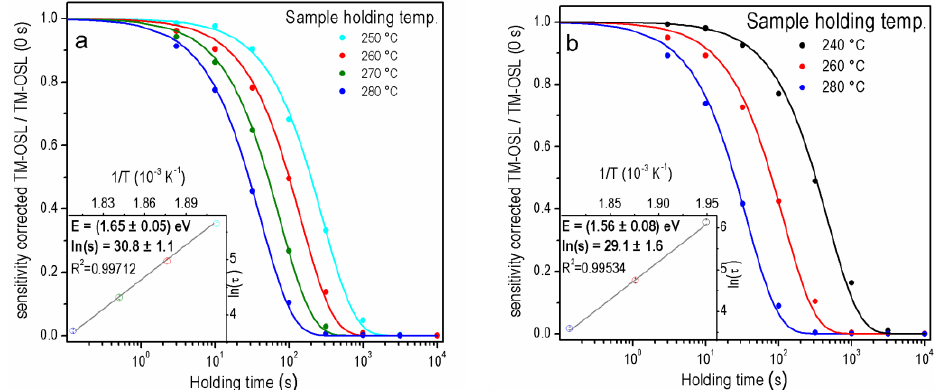
Figure 4. The OTDCs for one aliquot of the FB sample using TM-OSL 620 nm procedure after irradiation with dose 1000 Gy and preheating: ( a ) 280 °C, FOM 250 = 1.89%, FOM 260 = 3.17%, FOM 270 = 2.03%, FOM 280 = 2.33%, ( b ) 150 °C, FOM 240 = 2.75%, FOM 260 = 4.13%, FOM 280 = 3.91%.